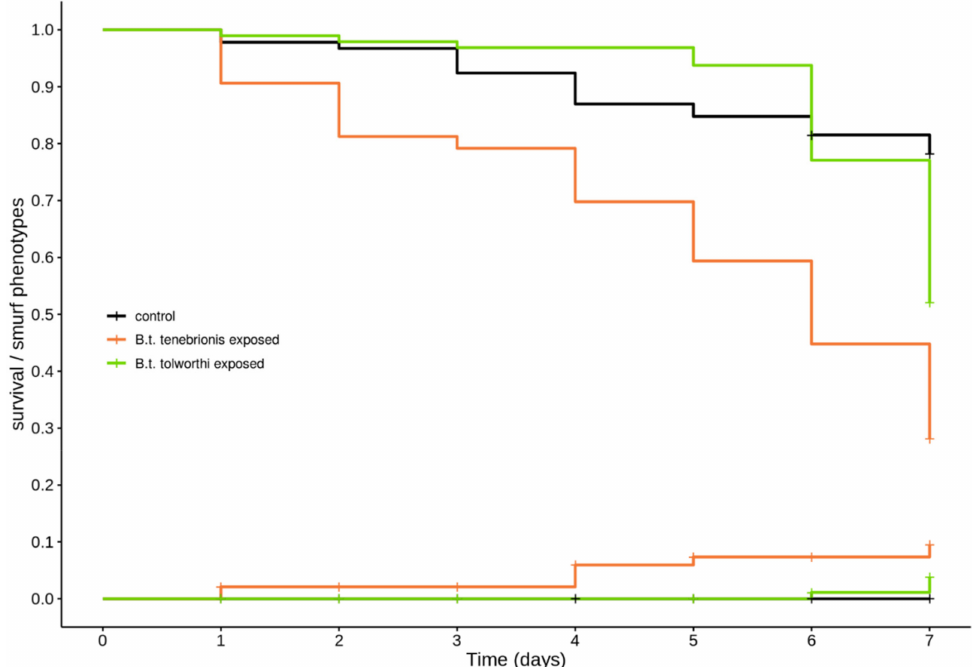
Figure 5. Survival and occurrence of Smurf phenotype in 15-day-old T. castaneum larvae exposed to Bacillus thuringiensis var. tolworthi and B. thuringiensis var. tenebrionis . Kaplan–Meier curves representing the survival (descending lines) and the cumulative incidence of Smurf phenotypes (ascending lines) in 15-days-old T. castaneum larvae exposed to a control diet (in black), 2.5 × 10 9 CFU / mL of B. thuringiensis var. tenebrionis (in orange) and 2.5 × 10 9 CFU / mL of B. thuringiensis var. tolworthi (in green) spores and crystals mix. Data in Table